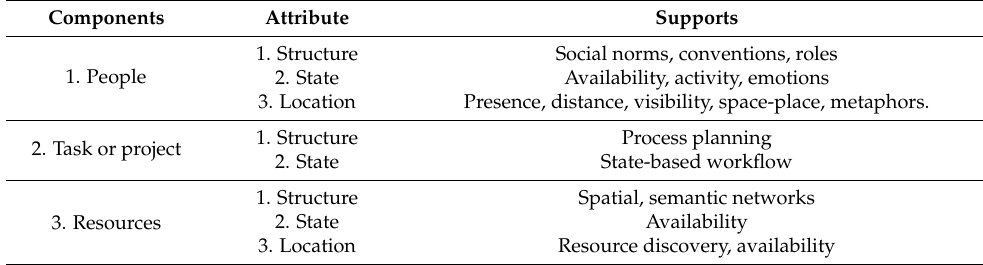
Table 12. Awareness